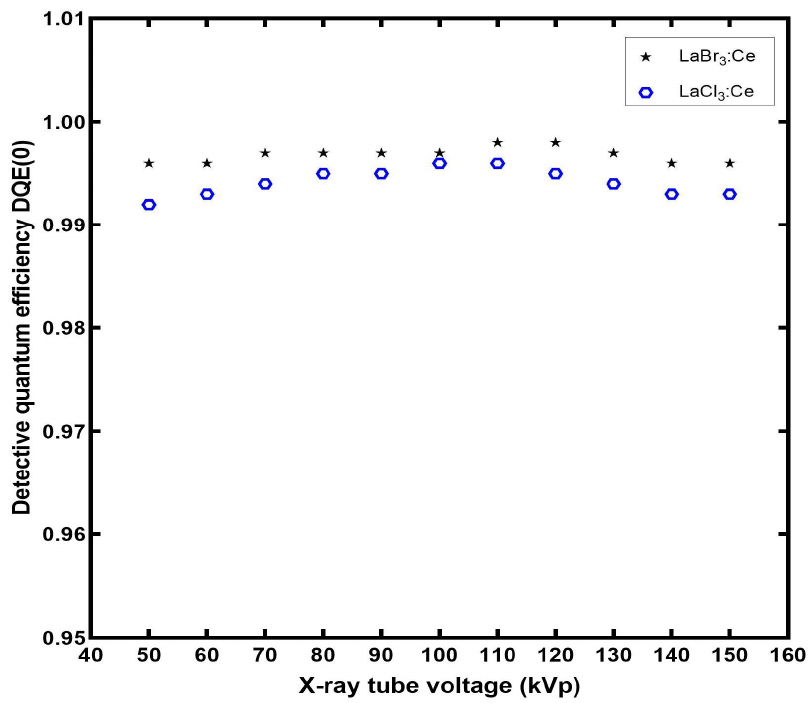
Figure 19. DQE(0) of the LaBr 3 :Ce and LaCl 3 :Ce single crystals.